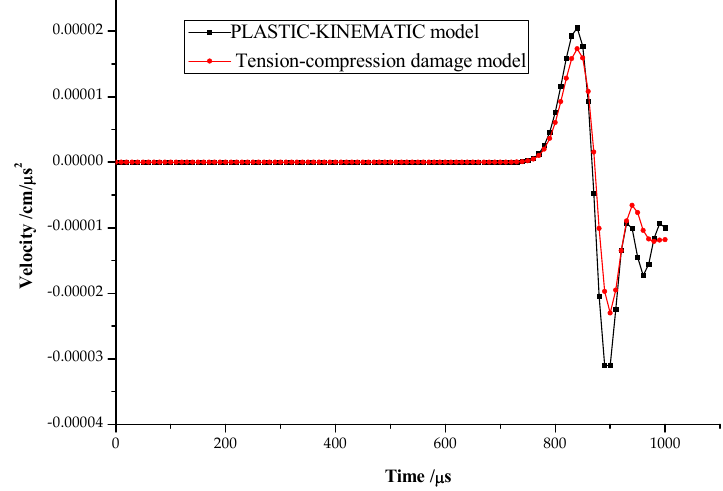
Figure 7. Velocity–time curves for monitoring point 1.